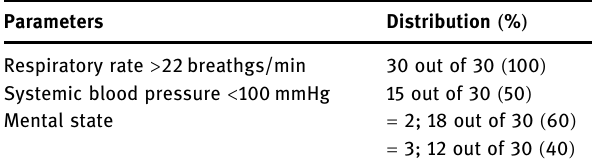
Table 3: qSOFA criteria and scoring